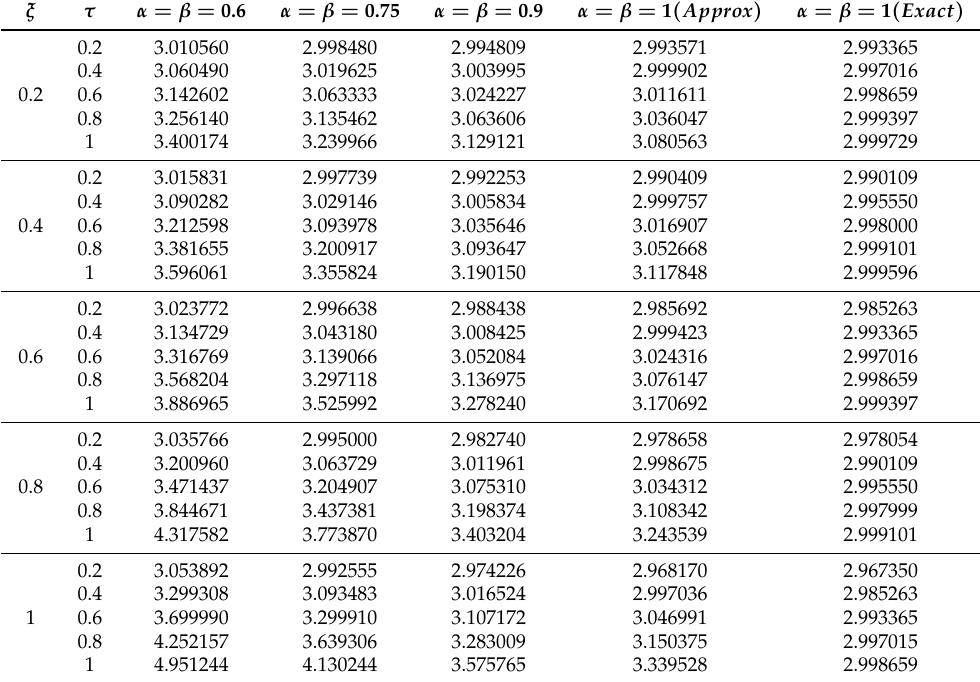
Table 5. The exact, NTDM CF and NTDM ABC solutions of v ( ξ , ζ , τ ) for Example 2 at different fractional-order of α and β with l = 4 for different ξ and τ when ζ = 1.